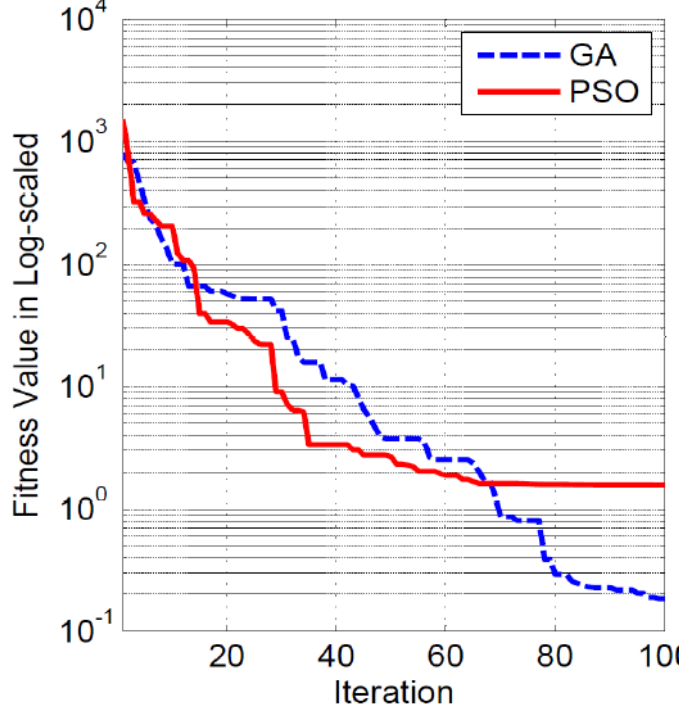
Fig. 4 GA-MAS and PSO algorithm iteration